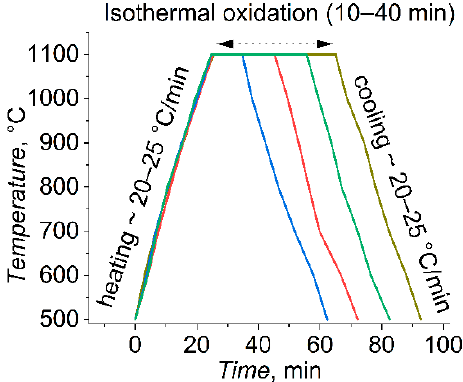
Figure 1. Temperature profiles during oxidation tests.